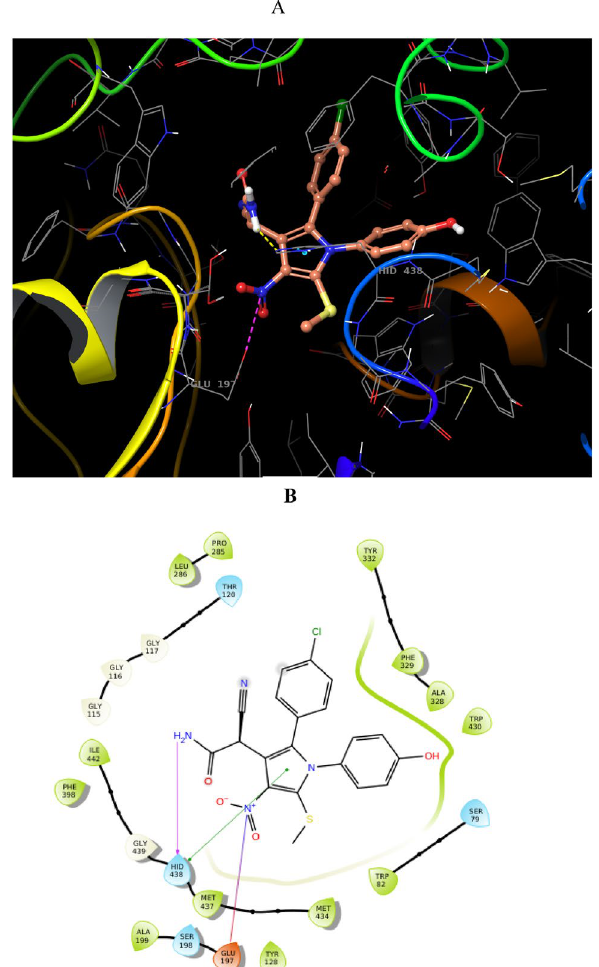
Figure 10. ( A ) 3D Binding pattern of 4ad within the active site of BChE, ( B ) 2D binding interactions 4ad against